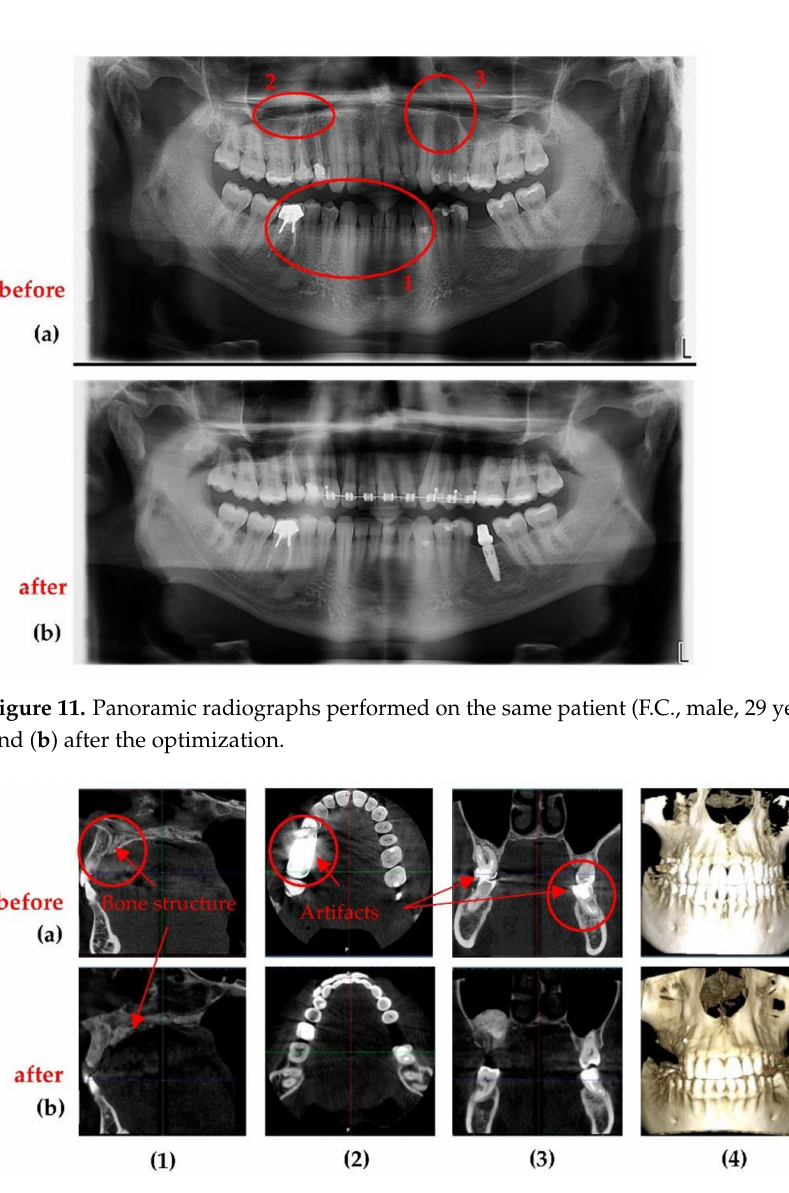
Figure 12. 3D CBCT performed on the same patient (F.C., male, 29 years old): images ( a ) before and ( b ) after the optimization. Notations: ( 1 ) axial, ( 2 ) sagittal, ( 3 ) coronal, and ( 4 ) 3D